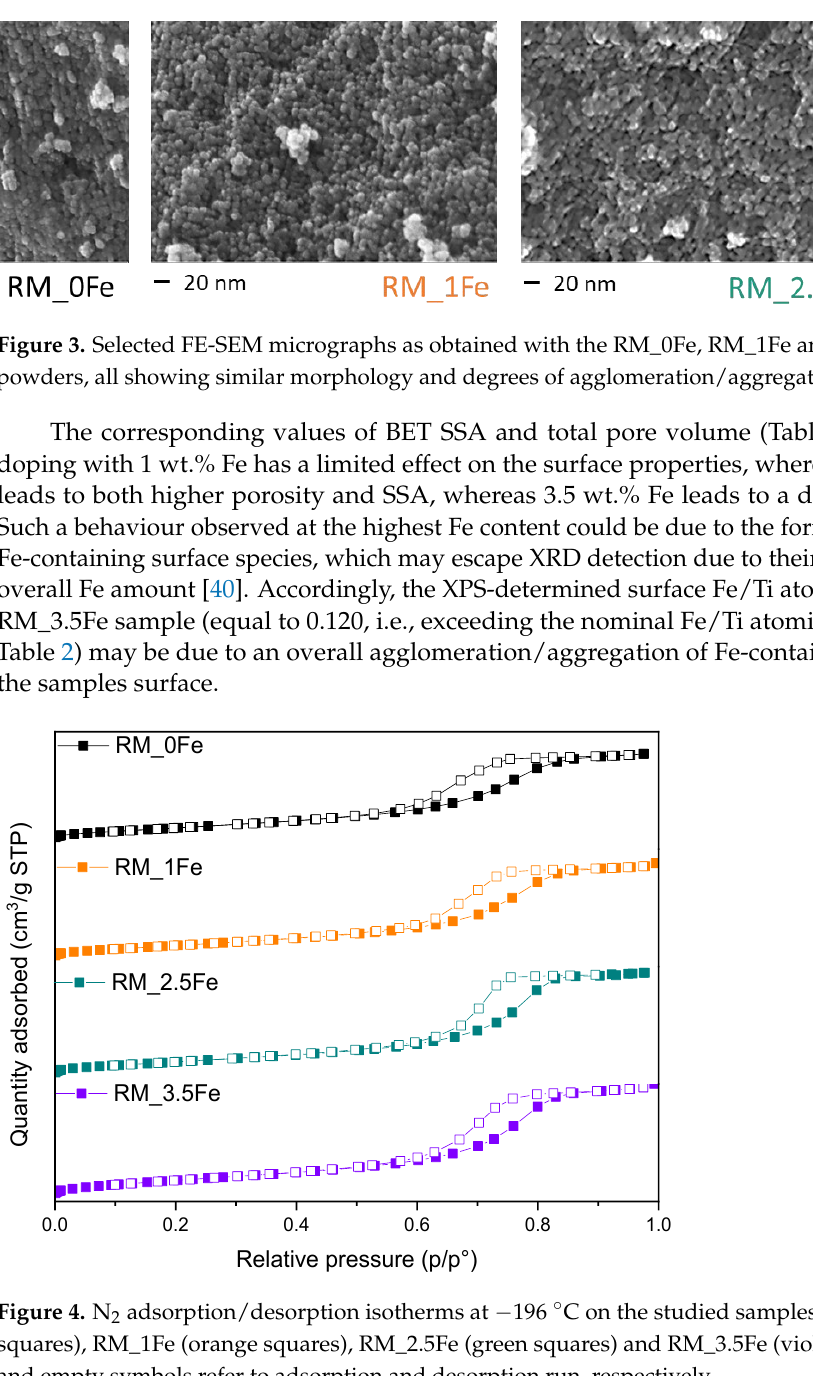
Figure 3. Selected FE-SEM micrographs as obtained with the RM_0Fe, RM_1Fe and the RM_2.5Fe powders, all showing similar morphology and degrees of agglomeration/aggregation.